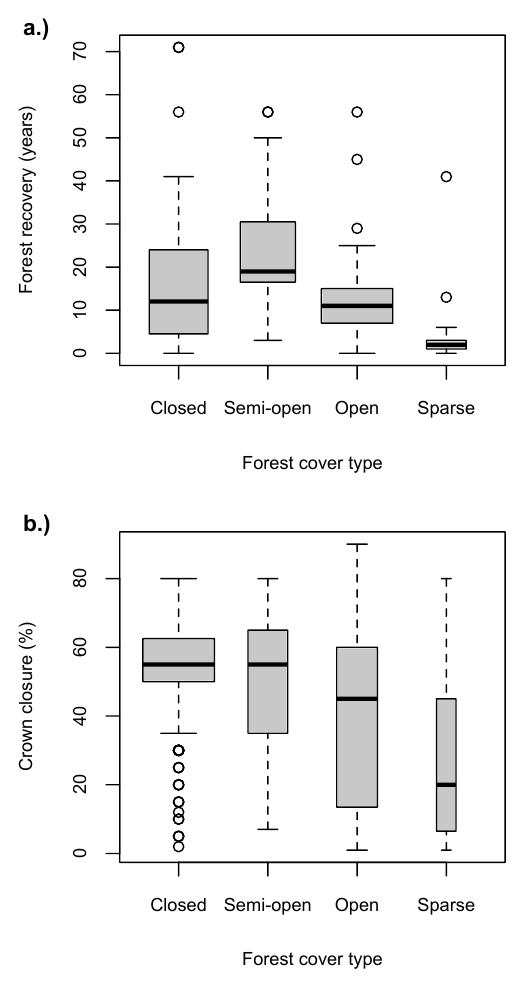
Figure 6. Box-and-whisker plots for characterizing the forest cover classification. (a) Forest recovery years since the last forest distur- bance were extracted to sample points that were within the BC for- est cutblock inventory (209 samples). (b) Crown closure (%) was extracted to each forest cover type where the sample data and VRI data overlapped (437 samples). The boxes’ widths are proportional to the number of observations for each forest cover type.